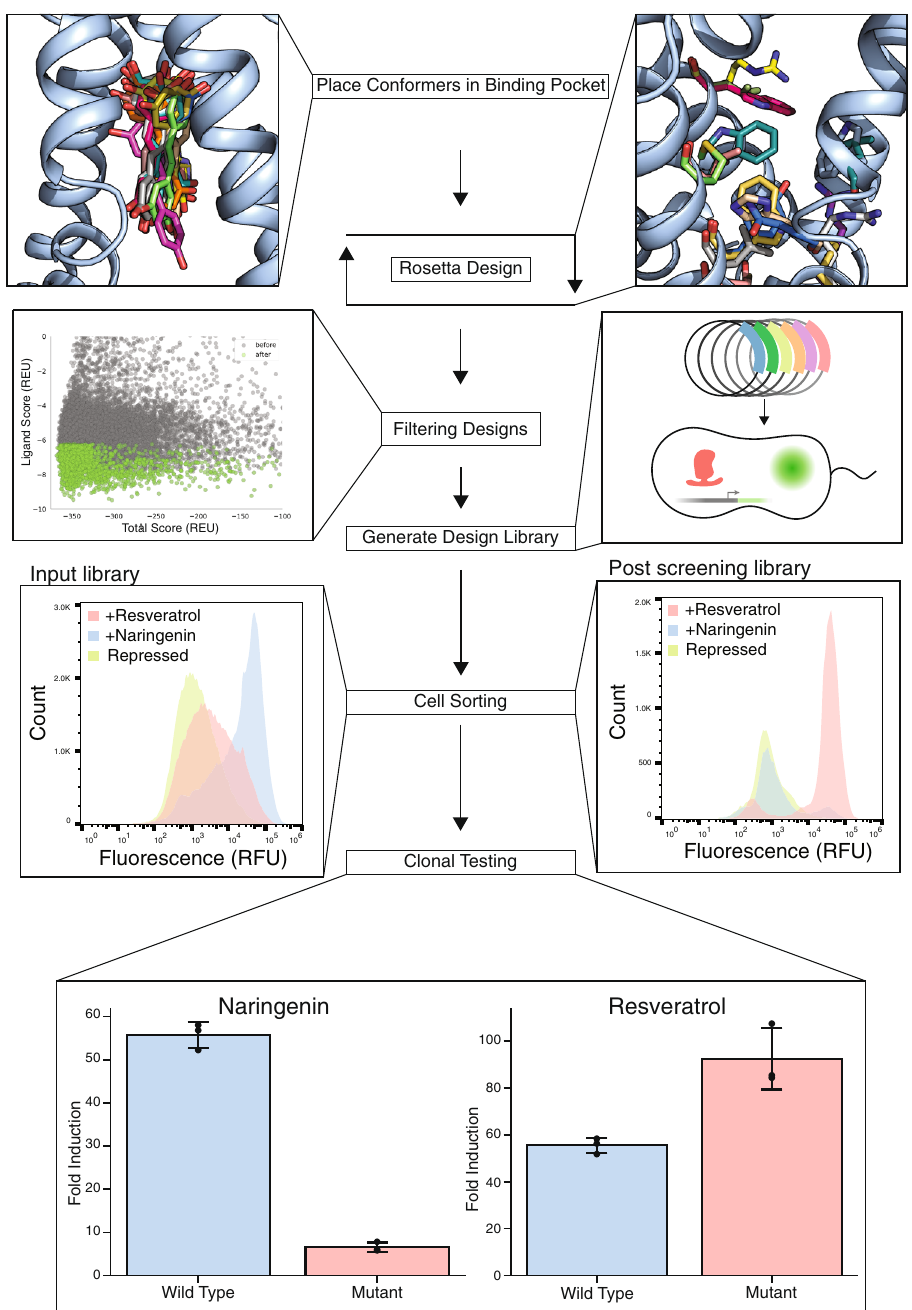
Fig. 1 Design of resveratrol-speci fi c TtgR variant. Resveratrol conformers are docked into TtgR followed by Rosetta-based computational design of the binding pocket. Candidates with favorable Rosetta score metrics (green points) are synthesized and cloned into an expression vector. Distribution of fl uorescence in cells containing uninduced TtgR variant library (light green), induced with naringenin (light blue) and resveratrol (red) before sorting (Pre- Sort) and after three rounds of sorting (Post-Sort) are shown. Colony screening identi fi ed a quadruple mutant showing resveratrol speci fi city: C137I/ I141W/M167L/F168Y. The quadruple mutant phenotype was compared to wild-type in biological triplicate ( n = 3) by inducing each with either 1000 μ M naringenin or 100 μ M resveratrol. The error bars denote the standard deviation of the fold induction for the triplicate measurements (see “ methods ” (Supplementary Figs. 1, 2). The mutations generated in the 3500 sequences are diverse, but designed sequences generally favor the wild-type amino acid at each mutable position (Supplementary Fig. 2). A few positions such as 96, 137, 168, and 175 have mutations that are more abundant than the wild- type amino acid. We synthesized oligonucleotides encoding approximately 3500 designed variants as a pool of exact chip- DNA sequences (Twist Bioscience Inc).